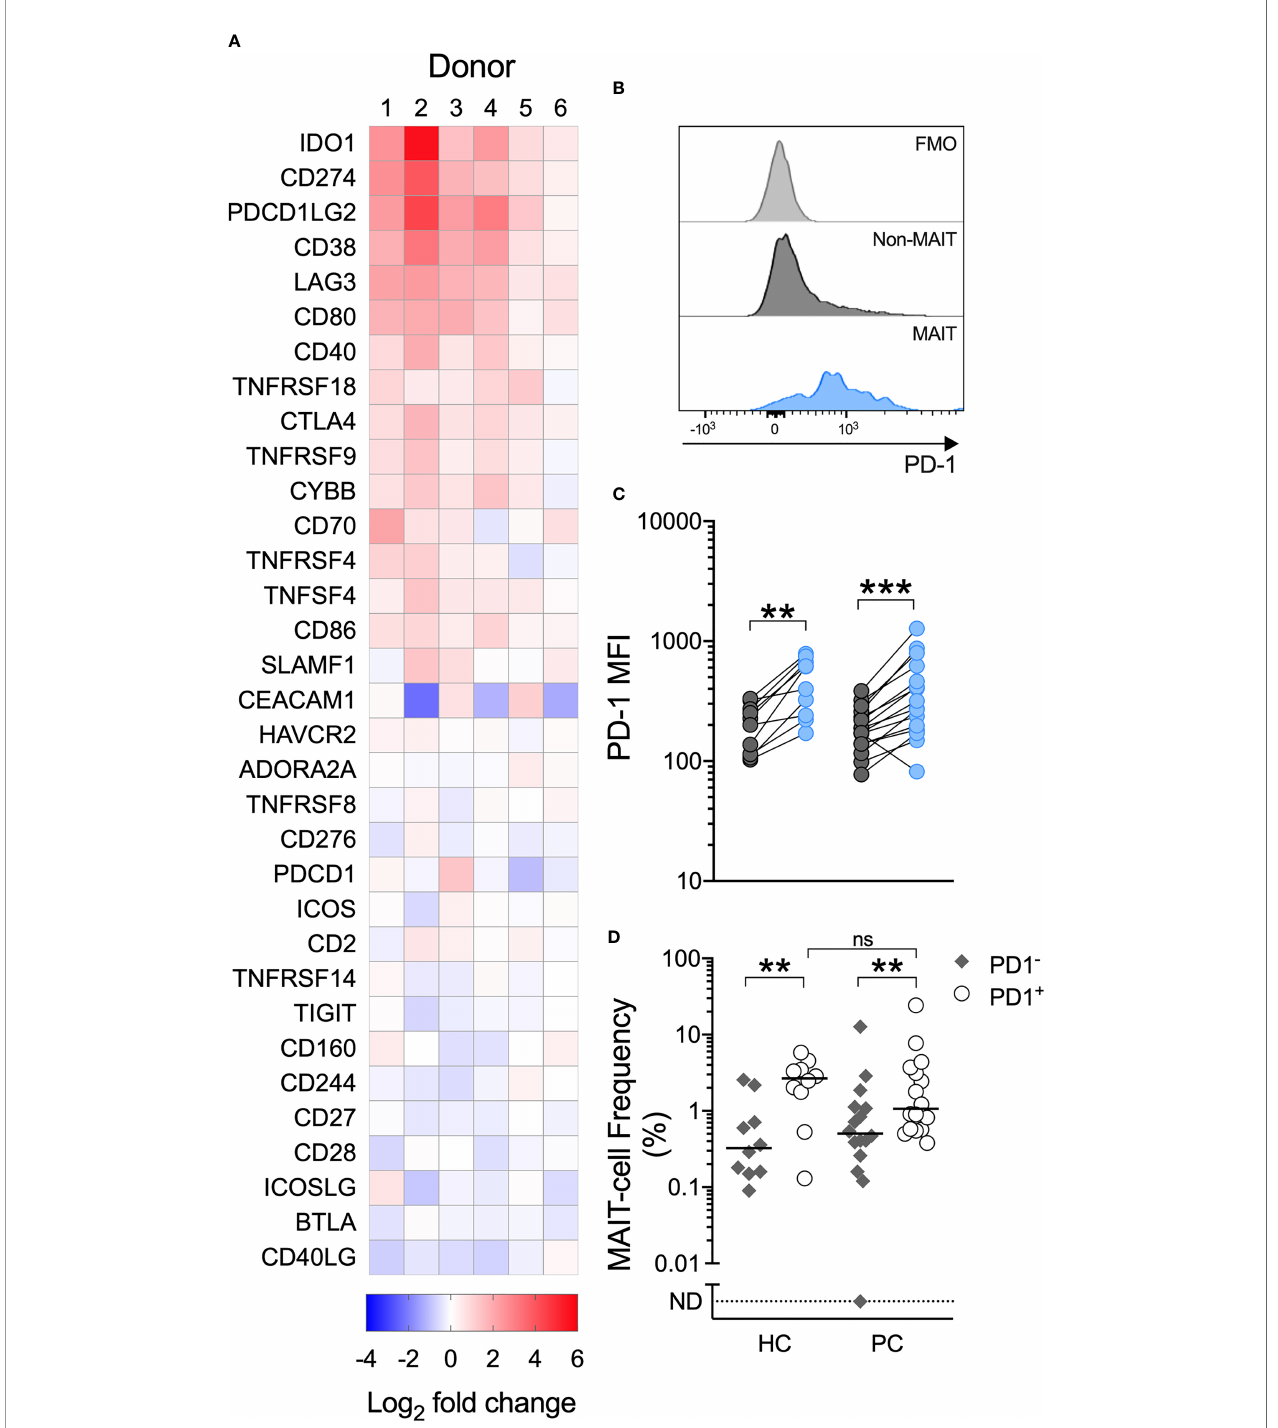
FIGURE 4 | A MAIT-cell speci fi c agonist upregulates PD-1 ligands, circulating MAIT-cells express high levels of PD-1 and MAIT-cells are over-represented among PD-1 + T-cells. Immune checkpoint genes signi fi cantly upregulated by PBMCs cultured with 5-A-RU/MG are shown in (A) . N = 6 healthy donors. Flow cytometric analysis was used to determine the surface expression of PD-1 on MAIT and V a 7.2TCR - CD161 + /V a 7.2TCR + CD161 - T-cells in unstimulated PBMCs. Representative histograms (B) and surface PD-1 median fl uorescence intensity (MFI) (C) are shown. The proportion of MAIT-cells within the PD-1 + and PD-1 - fractions of PBMCs from healthy controls and men with prostate cancer is displayed in (D) . N = 20 healthy controls (HC), 36 men with prostate cancer (PC). ns, no signi fi cance. **P < 0.01. ***P < 0.001. ND, non detectable. ns, no signi fi